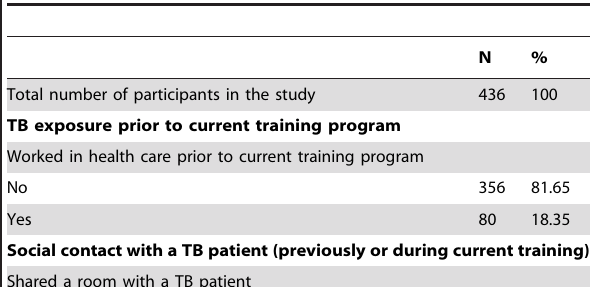
Table 3. Prevalence of TB exposure and risks factors (N=436).